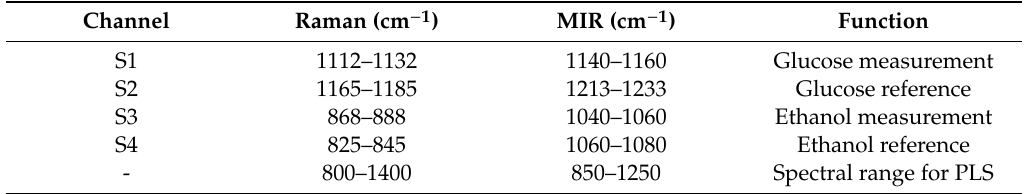
Table 1. Spectral regions for the evaluation of glucose, ethanol, and biomass (see below) by multiple linear regression (MLR) and partial least squares (PLS)